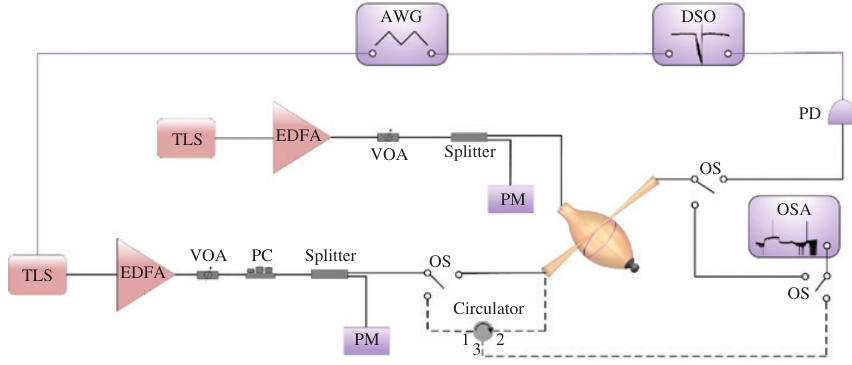
Figure 2: Schematic of the experiment setup of the tunable Brillouin and Raman lasers. TLS, tunable laser source; AWG, arbitrary waveform generator; DSO, digital storage oscilloscope; EDFA, erbium doped fiber amplifier; VOA, variable optical attenuator; PC, polarization controller; PM, power meter; OS, optical switch; OSA, optical spectrum analyzer; PD,